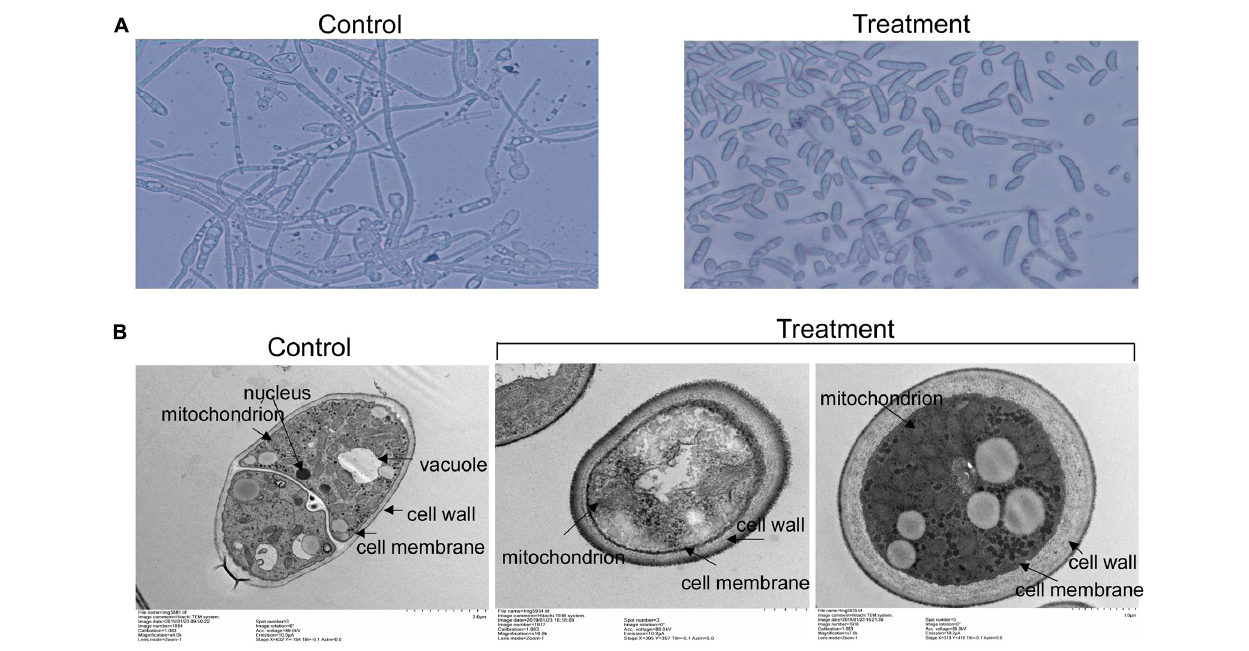
FIGURE 7 | Effects of strain SCA2-4 T extracts on spore germination and cell structure of Foc TR4. 10% of DMSO treatment was used as control. (A) Measurement of spore germination after treated with 16 × MIC of strain SCA2-4 T extracts. (B) Cell structure of Foc TR4 treated with 16 × MIC of strain SCA2-4 T extracts was detected using the transmission electron